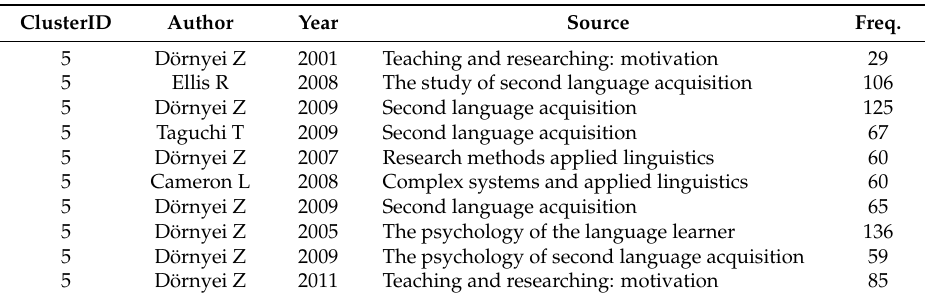
Table 7. The Members of Cluster #5.